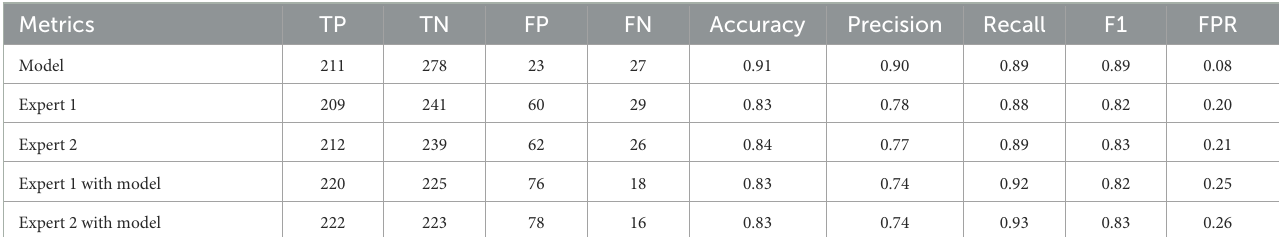
TABLE 3 Comparison of ensemble DL model and human